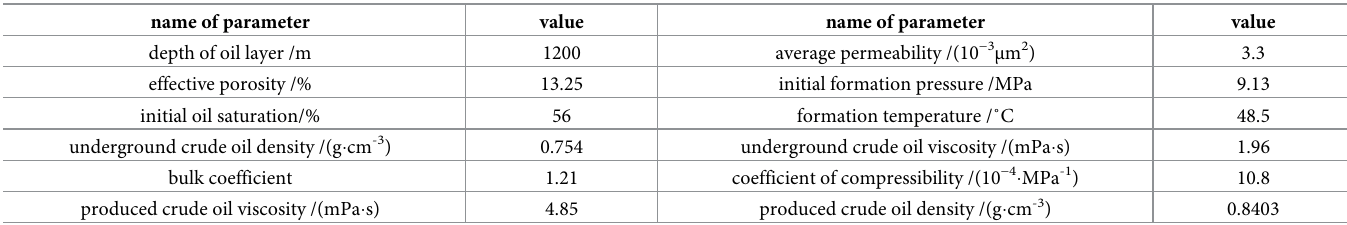
Table 3. Main parameters of simulation.